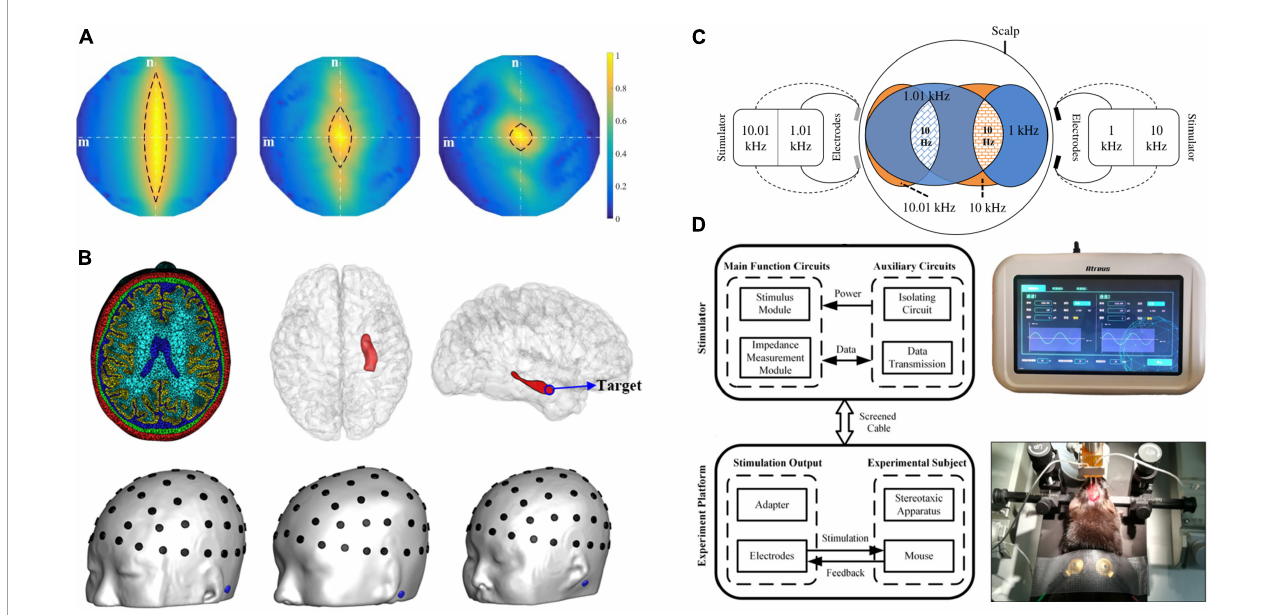
FIGURE2 Various TI electrical stimulation optimization strategies. (A) Multi-electrode stimulation: the more electrode pairs employed, the more focal stimulation in the brain can be accomplished (Song X. et al., 2021). (B) Algorithm optimization of stimulation parameters to discover the best electrode configuration and injection current across 61 candidate electrodes on the scalp. The right hippocampal head is the stimulation target (Lee et al., 2020). (C) Multi-Point Temporal Interference (MTI) method: MTI used a single electrode delivering currents with different frequencies to stimulate multiple target areas in the brain simultaneously (Zhu et al., 2019). (D) Hardware: the stimulator could precisely position targets and measure bioimpedance in real-time during TI electrical stimulation (Wang et al.,